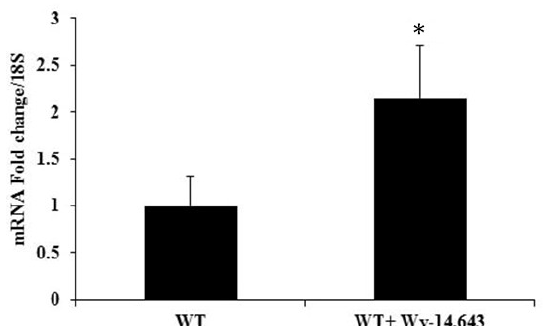
Figure 6. mRNA levels of cTnI , an indicator of failing heart, were increased in the hearts of WT mice treated with Wy-14,643: WT mice were injected with 250 mg/kg body weight of Wy-14,643 and hearts were excised 24 h after the treatment. Total RNA from the hearts were analyzed by RT-qPCR, which revealed a ~2-fold increase in mRNA levels of c TnI in the hearts of the mice treated with Wy-14,643 as compared to the controls. The data were analyzed by t -test, n = 4–6 per group, * p < 0.05.